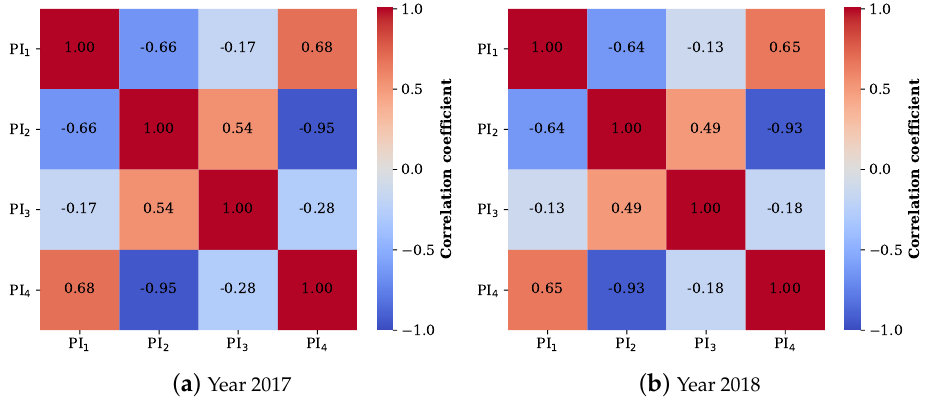
Figure A1. Spearman’s ρ correlation coefficients between poplar index (PI) variants based on all resampled dates for 2017 and 2018 S2 time series.